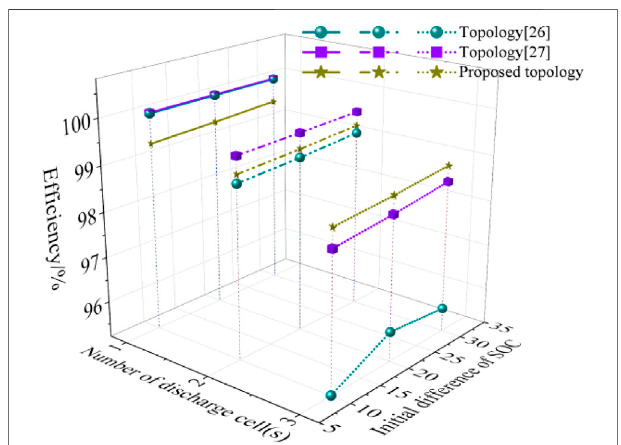
FIGURE 7 | Balancing ef fi ciency comparison.